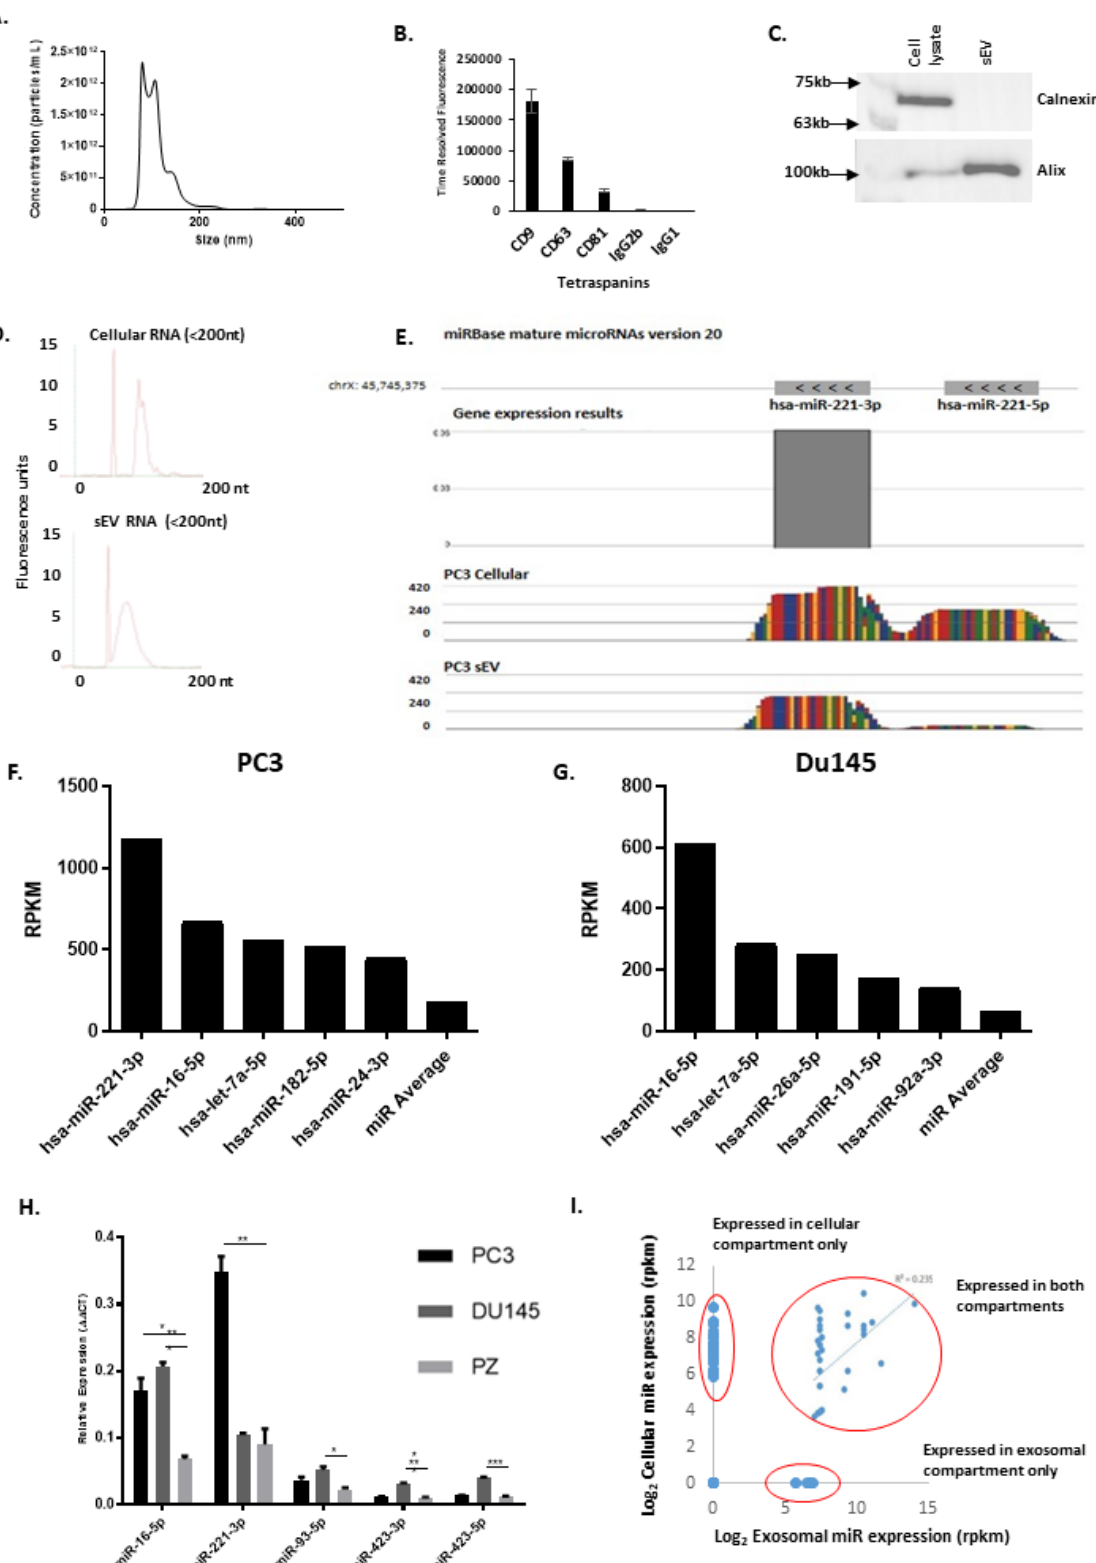
Figure 4. Extracellular Vesicle Characterisation and miR Cargo Identification . ( A ), Size distribution of isolated vesicles. sEVs isolated from PC3 cell conditioned medium using a sucrose cushion centrifugation, then analysed by nanosight NTA. ( B ), Immuno-phenotyping assay of PC3 sEVs for exosome associated tetraspanins CD9, CD63, and CD81 compared to isotype controls. Graph